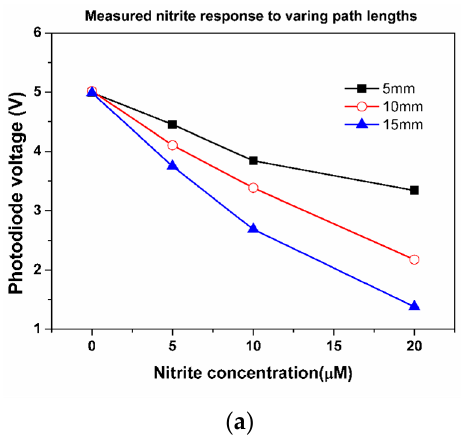
Figure 16. The results from the polymer injection moulded chips. A reduction in photodiode signal (voltage) is observed with the increasing Nitrite signal.